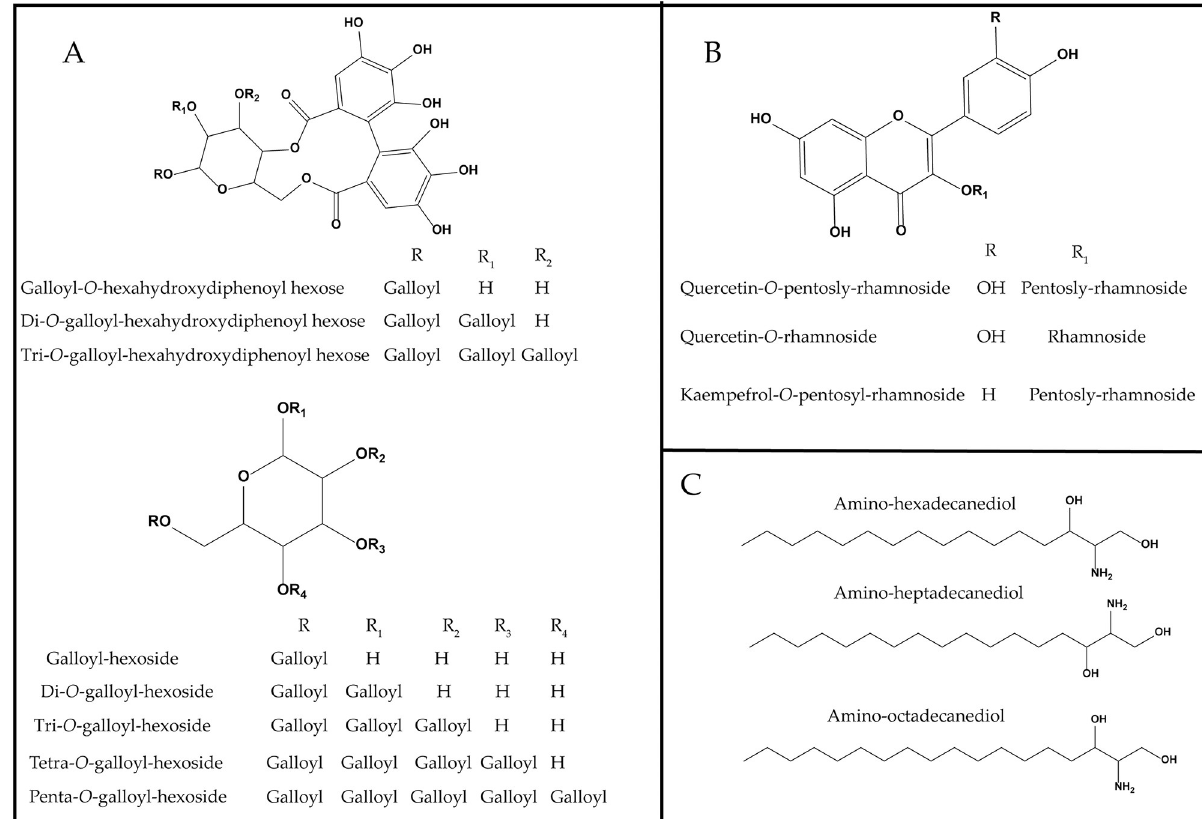
Fig 2. Major classes of phytochemicals: (A) tannins, (B) flavonoids, (C) amino alcohols detected in S . coriaceum leaf crude extract.